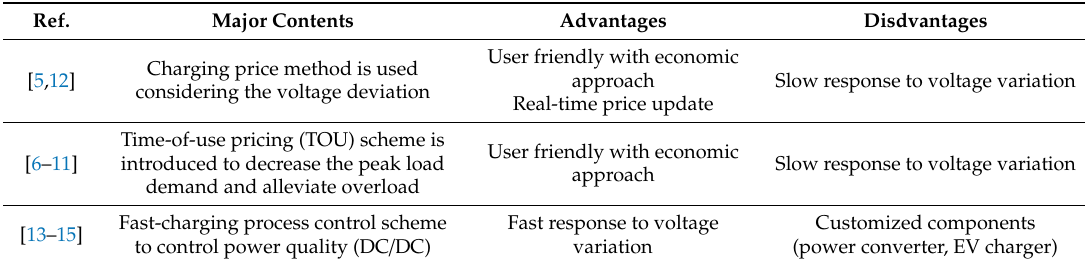
Table 1. Previous researches of stabilization of voltage on applications of an electric vehicle charging